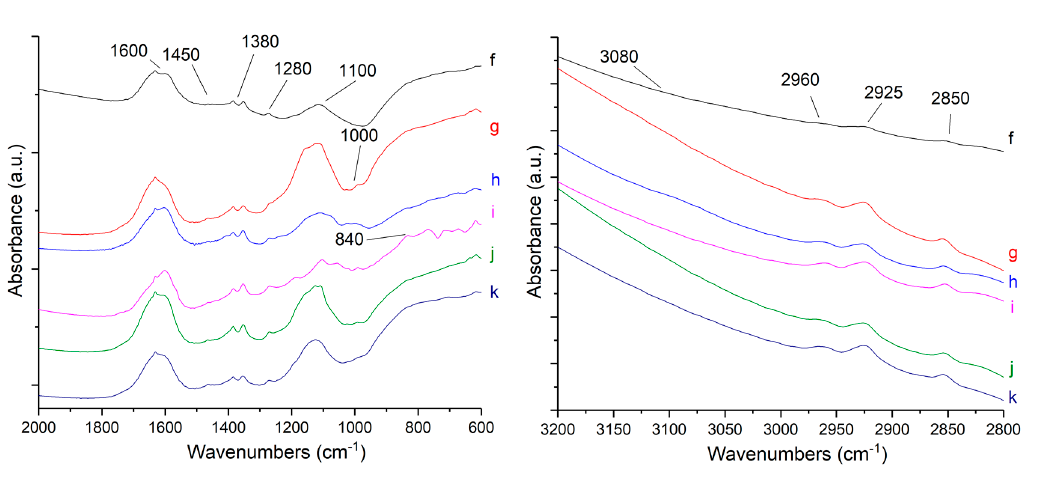
Figure 11. FT-IR spectra of CATs used for different years ( a ) as-prepared; ( b ) served for 1 year; ( c ) served for 2 years; ( d ) served for 3 years; ( e )served for 4 years.